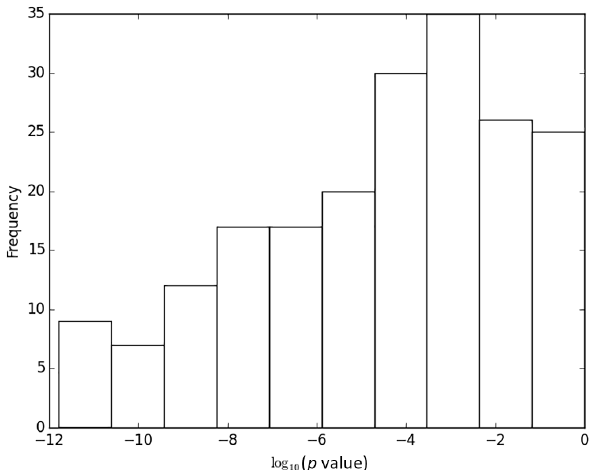
Figure 2. Histogram of p values from the omnibus tests across all days and response